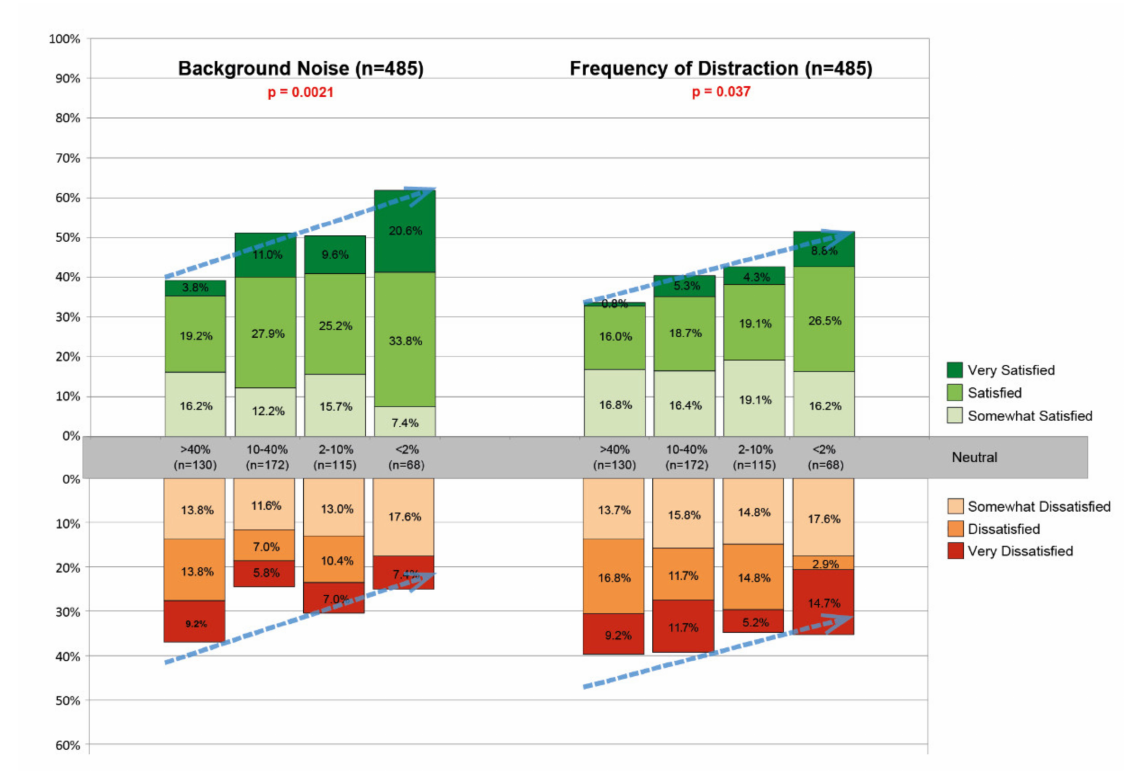
Figure 8. Acoustic satisfaction by percent of distributed noise sources: Background noise and frequency of